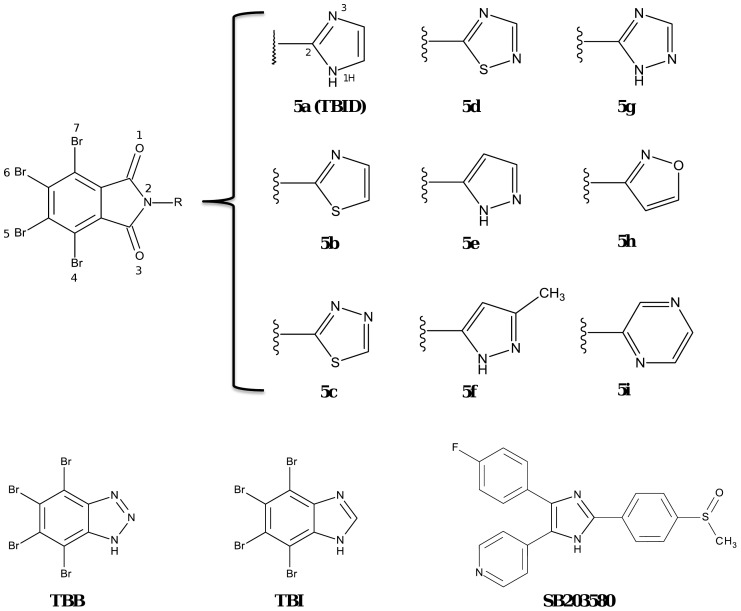
Structures of 2-aryl-4,5,6,7-tetrabromoisoindoline-1,3-dione derivatives.The 2-aryl-4,5,6,7-tetrabromoisoindoline-1,3-dione scaffold is shown on the left, in the upper part of the figure, where R was variably replaced in the individual compounds, as indicated on the right. In the lower part of the figure the formulae of TBB, TBI and SB203580 are reported for comparison.